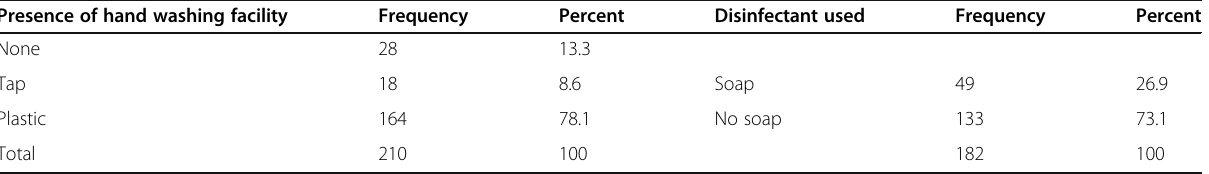
Presence of hand washing